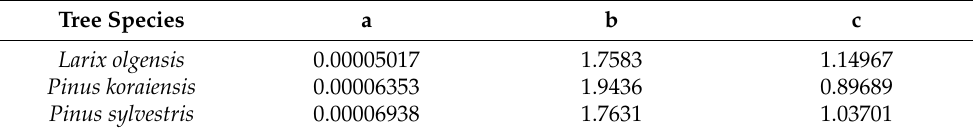
Table 1. The binary volume table parameters of main coniferous forest species in Northeast China [48]. Tree Species a b c Larix olgensis 0.00005017 1.7583 1.14967 Pinus koraiensis 0.00006353 1.9436 0.89689 Pinus sylvestris 0.00006938 1.7631